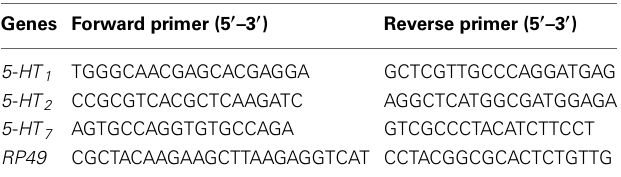
Table 1 | Primer sequences for